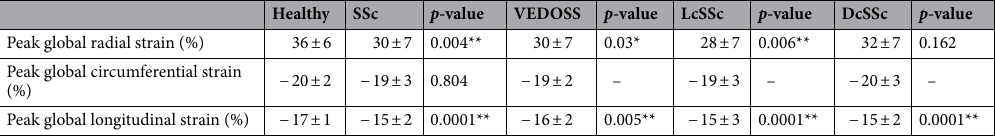
Table 2. Strain analysis. SSc: Systemic sclerosis; VEDOSS: very early diagnosis of systemic sclerosis; LcSSc: Limited cutaneous Systemic Sclerosis; DcSSc: Diffuse cutaneous Systemic Sclerosis; p: p -value. *Significant test; p -value less than .05. **Significant test; p -value less than